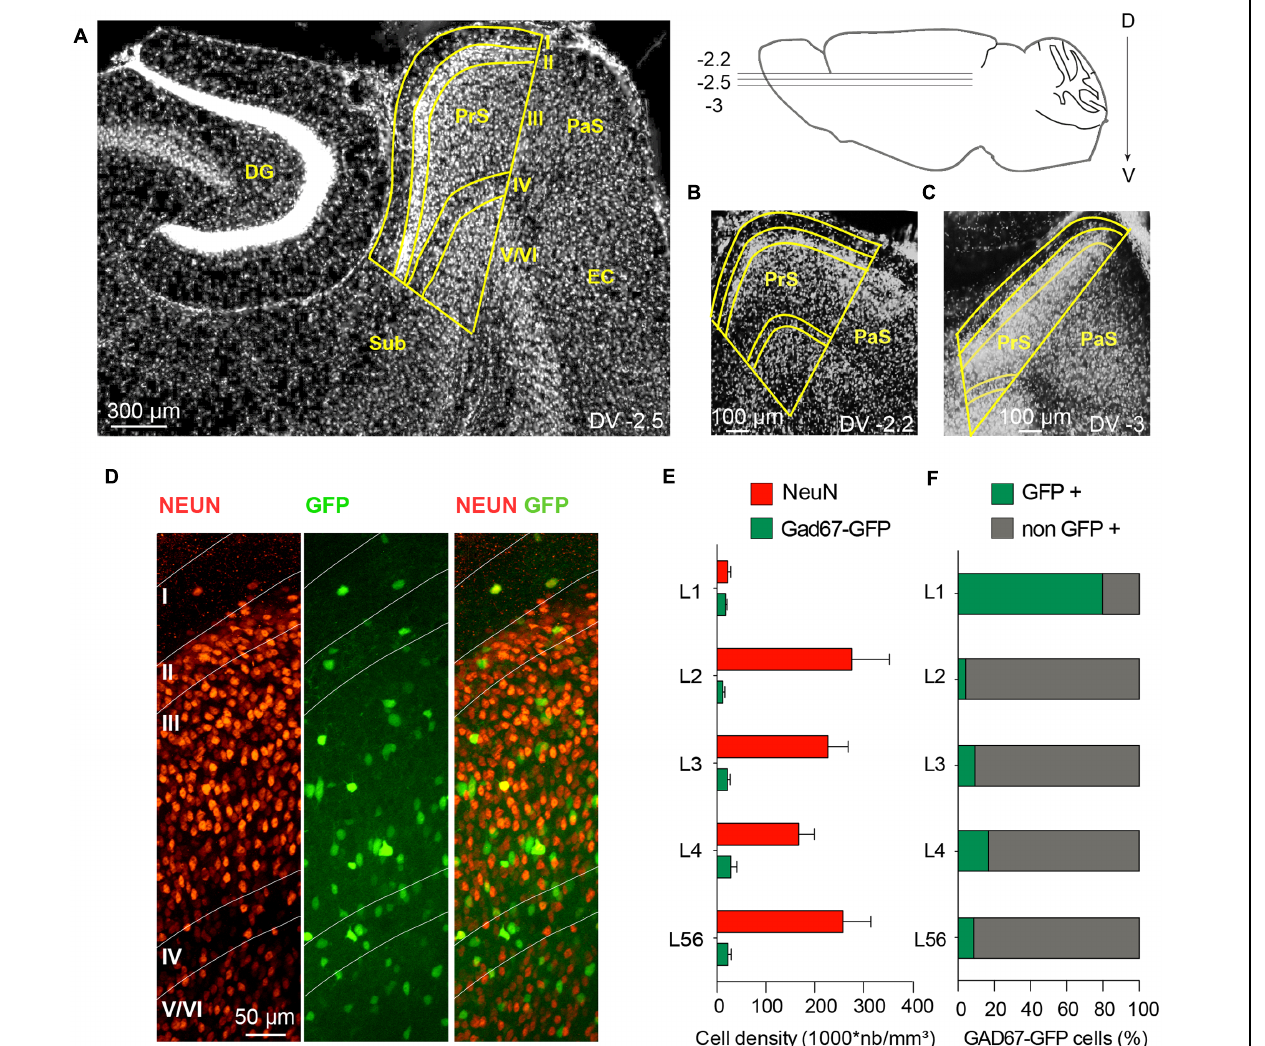
FIGURE 1 | Spatial distribution of GABAergic and non-GABAergic neuron somata in mouse presubiculum. (A) Horizontal section of mouse presubiculum (PrS) stained with DAPI. Dorso-ventral (DV) level − 2.5 mm. The presubiculum continues from the subiculum (Sub), faces the dentate gyrus (DG), and is adjacent to parasubiculum (PaS) and entorhinal cortex (EC). Changes in the disposition of these regions at DV − 2.2 mm (B) and DV − 3 mm (C) . (D) NeuN staining (left), GFP